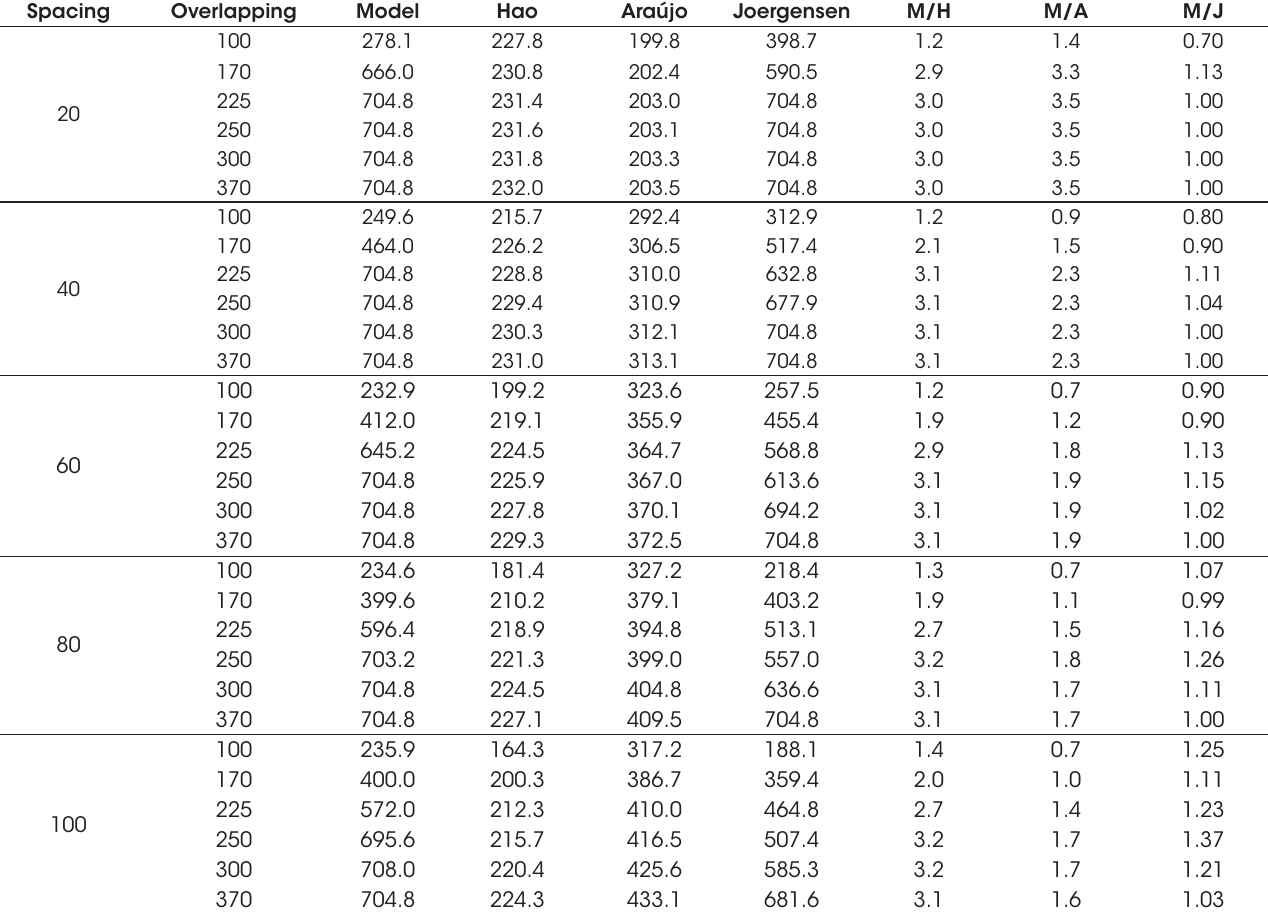
Comparison of the results with the analytical models